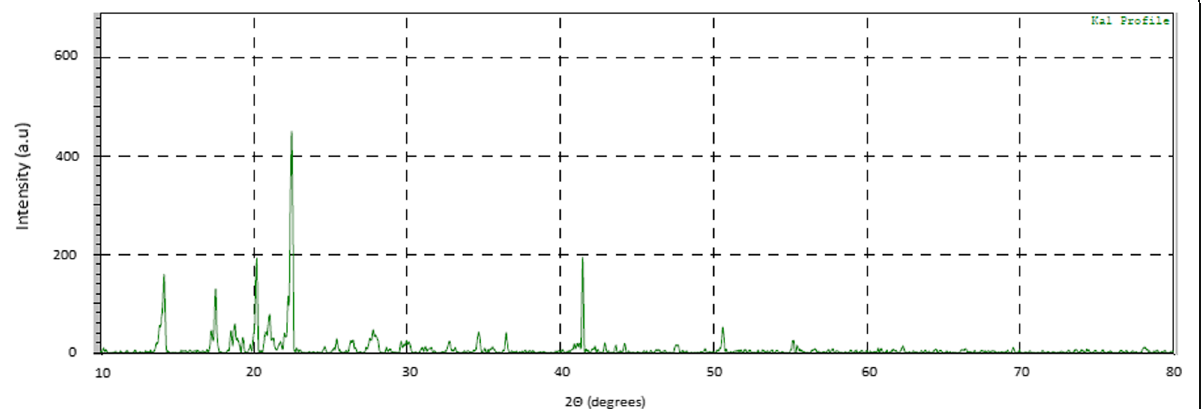
Fig. 8 XRD scan of crystals formed from 0.065 g/ml of solute in ethanol obtained by solvent evaporation method carried out for 48 h with no